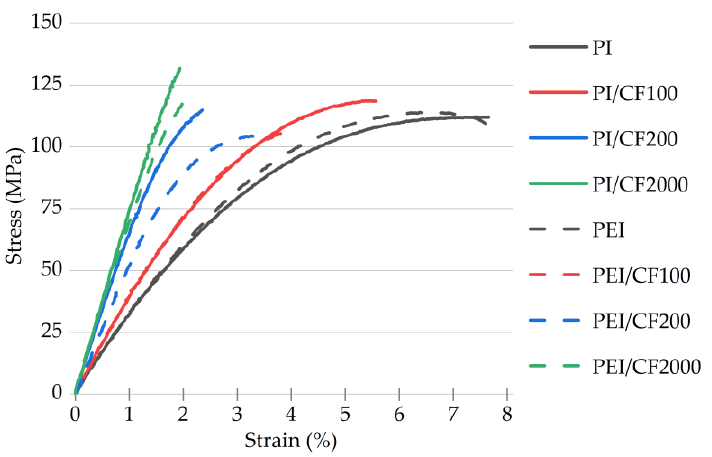
Figure 5. The engineering stress – strain curves for the PI- ( a ) and PEI-based ( b ) composites loaded with SCFs of various lengths.